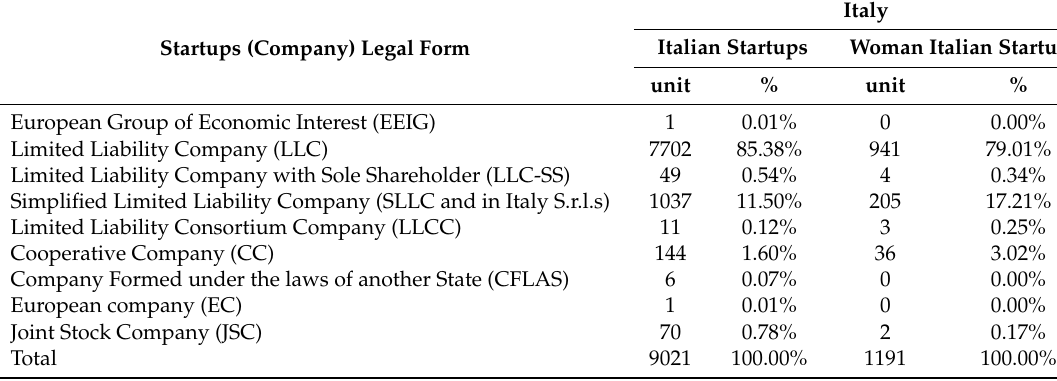
Table 6. Legal form of Italian startups and Italian woman